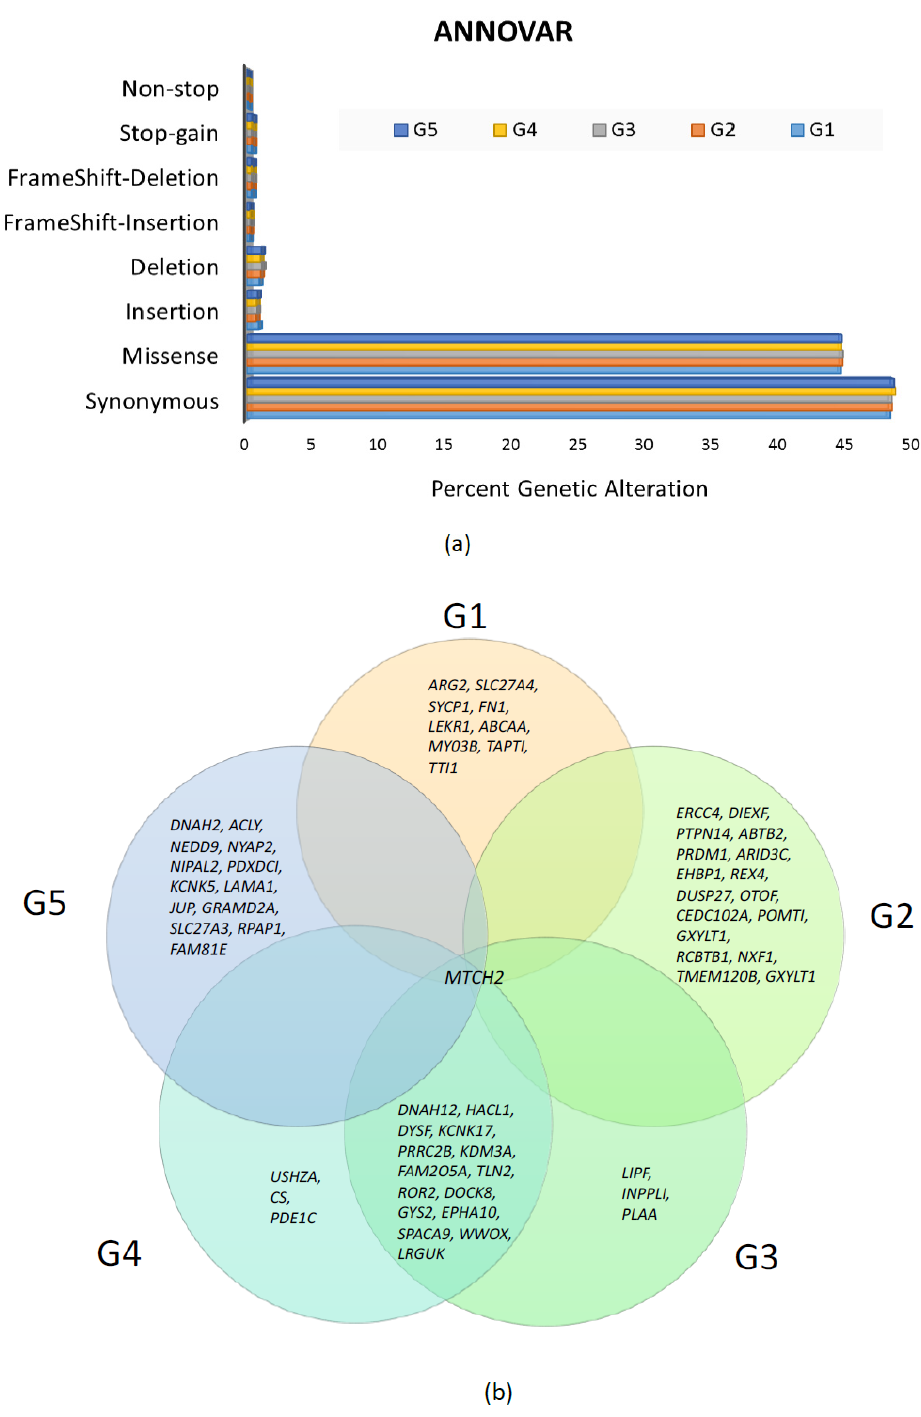
Figure 6. Landscape of genetic alterations by ANNOVAR. ( a ) Percent genetic alteration. ( b ) A Venn diagram showing the genes (of each patient sample) with mutations that met the criteria of being both rare and predicted as deleterious. Samples are indicated with the notations “G1-G2-G3-G4-G5” accordingly. Fifteen genes exhibited mutations that were common between samples G3 and G4 and only MTCH2 gene mutation was common across the five